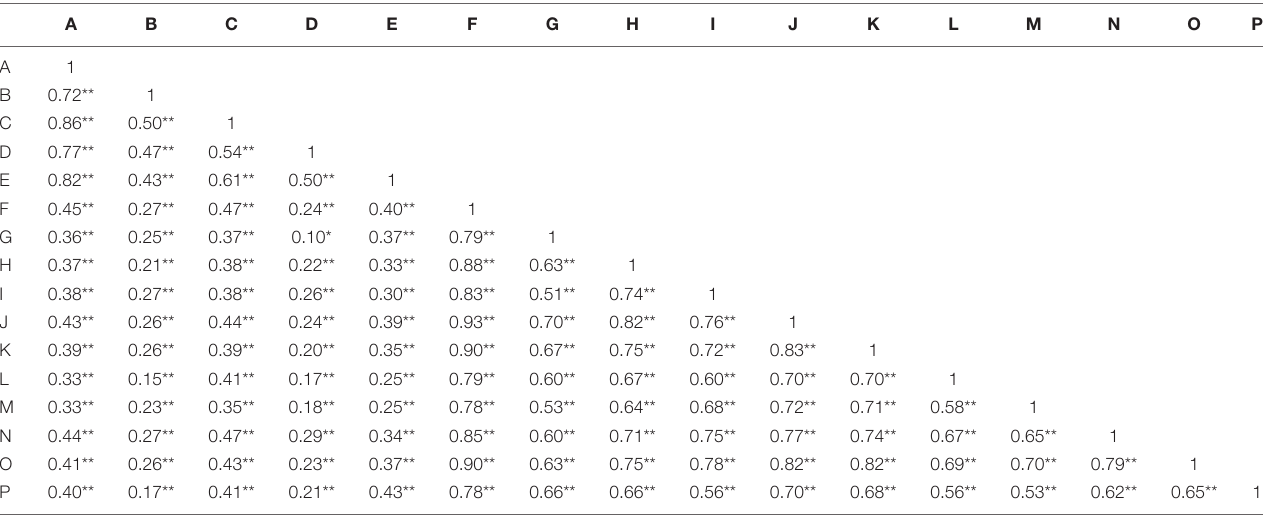
TABLE 9 | Correlation coefficients of each dimension in the SCL-90, PSQ, and NEO-FFI-N for metro